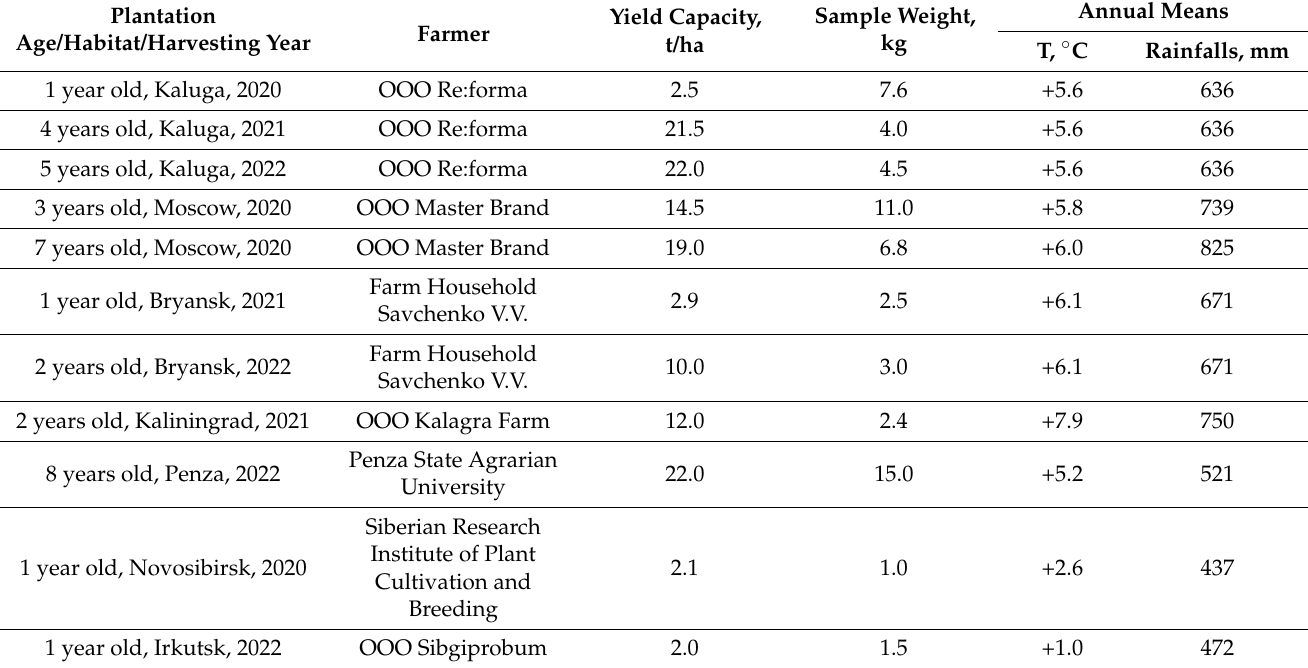
Table 1. Data on harvesting year, farmers and yield capacity (calculated), sample weight and climatic conditions for cultivation of Miscanthus × giganteus differing in plantation age and habitat